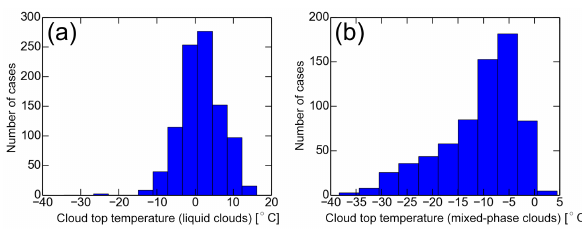
Figure 5. Distribution of cloud-top temperature for all pure liq- uid (a) and mixed-phase (b) cloud layers detected between 2011 and 2015 over Leipzig.